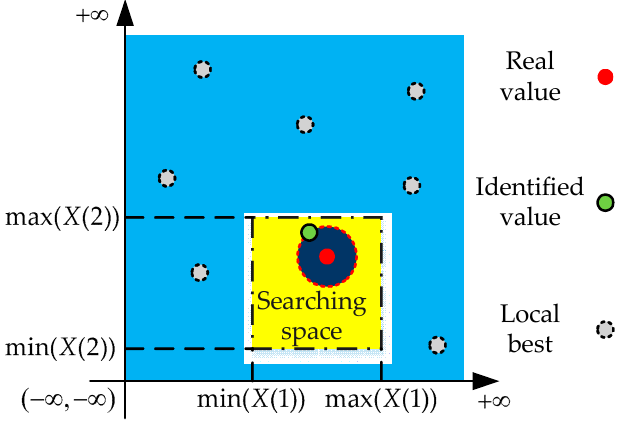
Figure 3. Two-dimensional search space.